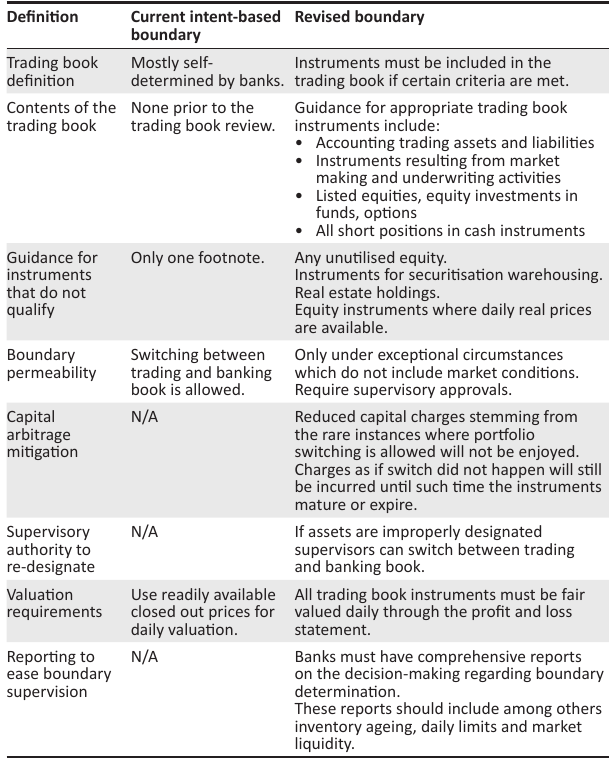
TABLE 1: Boundary definitions of Basel II and Basel IV trading